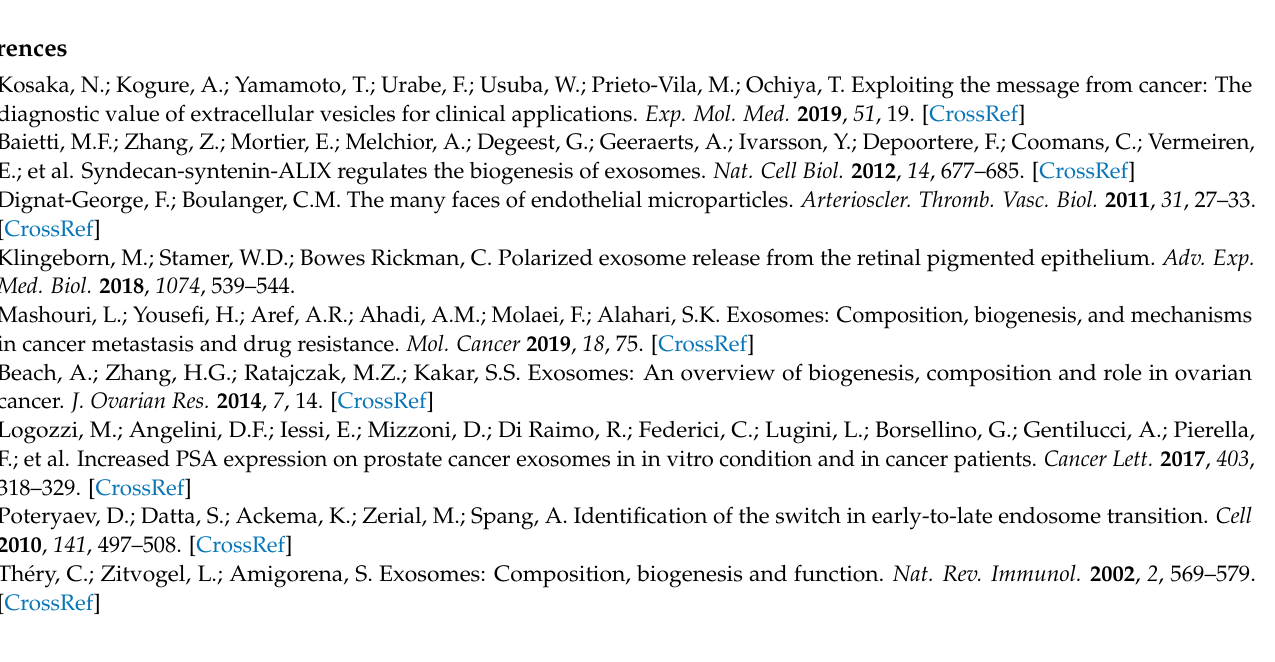
genes. Figure S7. Relative gene expression of RAB2B ( A ), RAB3B ( B ), RAB27A ( C ), STX1A ( D ), and VAMP7 ( E ), with regards to the presence of distant metastasis. No statistically significant association was observed between the presence of distant metastasis and relative expression of those genes. Figure S8. Relative gene expression of RAB3B ( A ), RAB9A ( B ), RAB11B ( C ), RAB27A ( D ), RAB27B ( E ), and STX1A ( F ) with regards to the T status from the TNM classification system. No statistically significant association was observed between the T status from the TNM classification system and relative expression of those genes. Figure S9. Kaplan Meier curves for 5-year overall survival of RAB2B ( A ), RAB3B ( B ), and VAMP7 ( C ). No statistically significant differences are observed between 5-year survival and relative expression of those